Question: Provide a one-line summary of what is displayed.
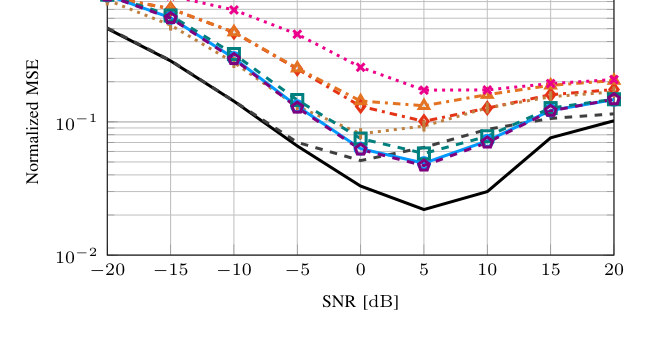
Answer: MSE performance with one (top) and three (bottom) propagation cluster, N = 64 antennas, and P = 16 pilot observations.